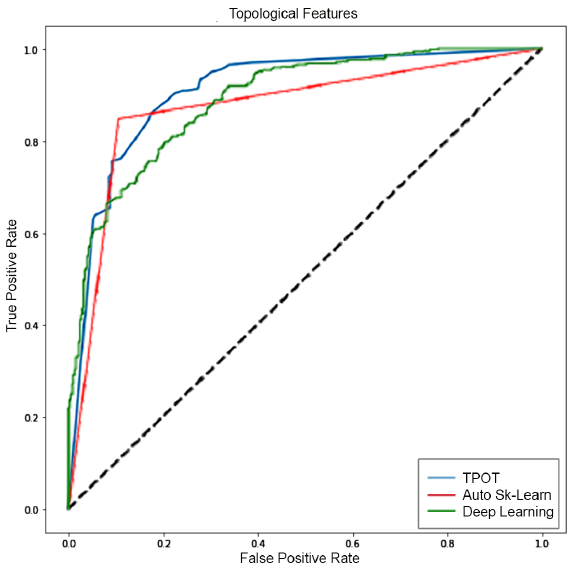
Figure 13. Comparison of ROC curves for the three machine learning approaches trained with topological features.